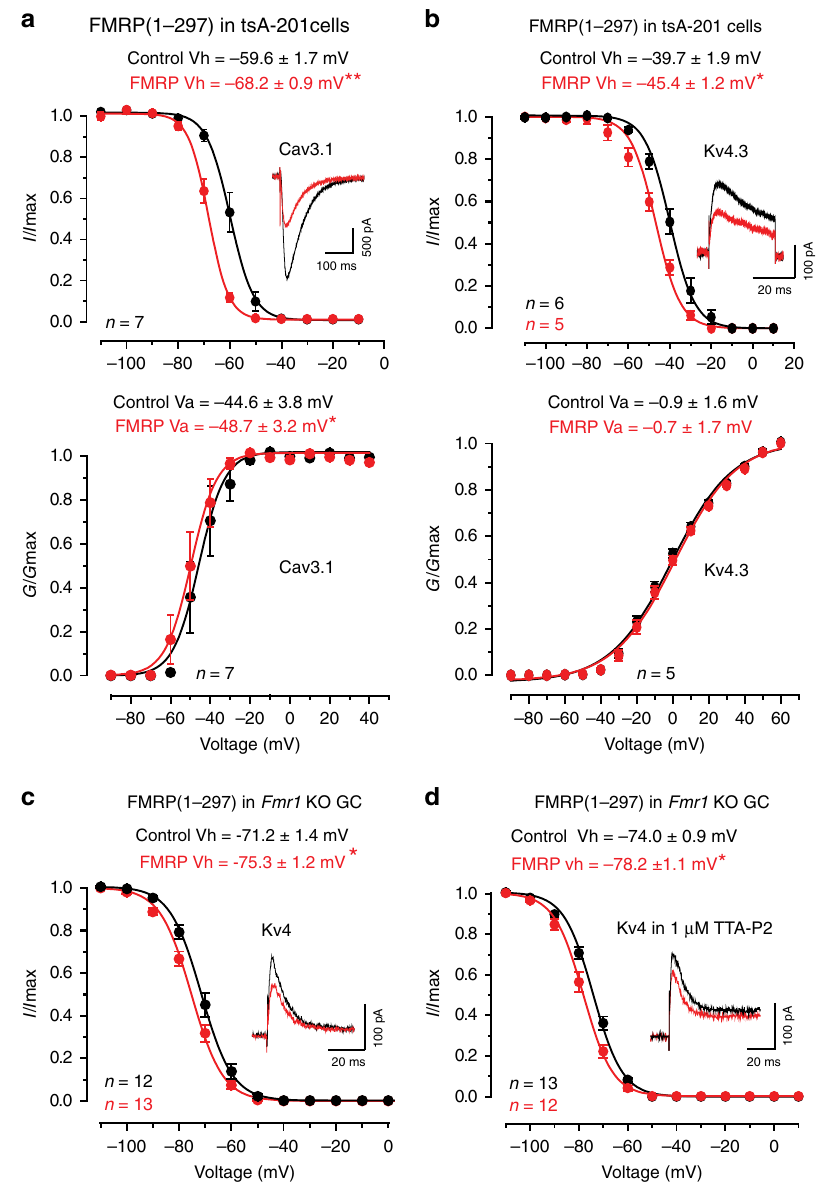
Fig. 3 FMRP reduces the availability of Cav3.1 and Kv4 current. FMRP(1 – 297) (30 nM) was introduced by direct infusion through the electrode ( a ) and in ( b ) using separate cell populations with or without FMRP(1 – 297) in the electrode. FMRP(1 – 297) infusion for 10 min promotes a signi fi cant left-shift in Vh and Va of Cav3.1 ( a ) (Vh, p = 0.0021; Va, p = 0.02, both with paired-sample t test), and of the Vh of Kv4.3 ( b ) (Vh, p = 0.039, two-sample t test; Va, p = 0.346, paired-sample t test) when included in the electrode. Insets show superimposed recordings of current evoked by depolarizing to − 30 from − 70 mV (Cav3.1) ( a ) or − 50 mV (Kv4.3) ( b ). c In granule cells of Fmr1 KO mice including 30 nM FMRP(1 – 297) in the electrode signi fi cantly left-shifts Kv4 Vh ( p = 0.037 with two-sample t test) and reduces Kv4 current (inset). No effect was detected on Kv4 Va under these conditions. d Including 30 nM FMRP(1 – 297) in the electrode for Fmr1 KO granule cells induces a left-shift in Kv4 Vh in the presence of 1 µ M TTA-P2 to block Cav3-mediated calcium in fl ux ( p = 0.008 with two-sample t test). Average values are mean ± s.e.m. and sample values at the base of plots in ( c , d ) indicate the number of cells drawn from 3 animals. * p < 0.05, ** p < 0.01. Animals used in ( c , d ) were P16 – 22. GC granule cell. Source data are provided as a Source Data fi